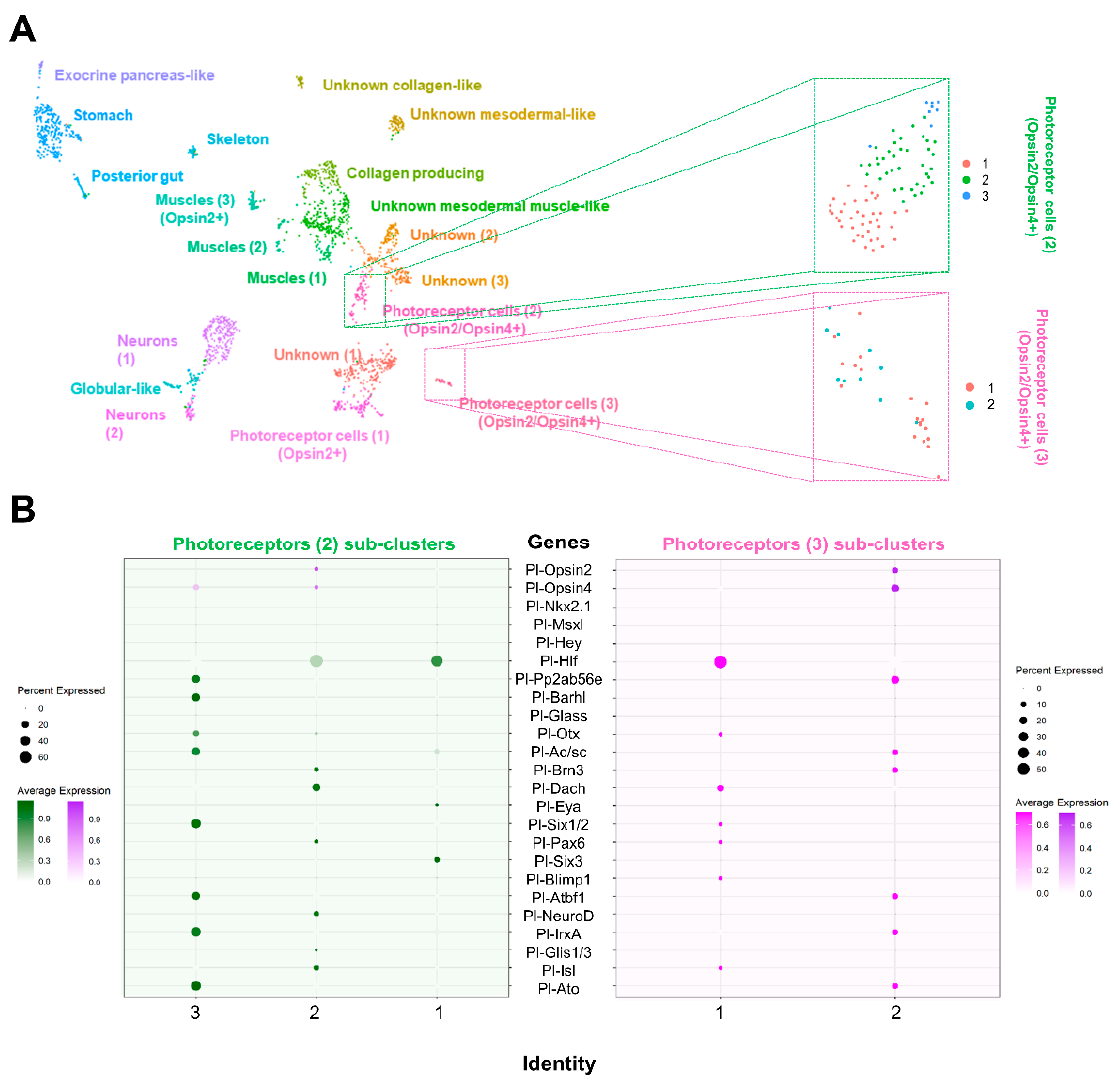
Figure 3. Distinct molecular signature of the two opsin2 / opsin4 double positive cell type families. ( A ) Sub-clustering analysis of the two opsin2/opsin4 double positive cell type families resulted in the generation of the three and two distinct sub-clusters, respectively. ( B ) Dotplot showing the average scaled expression of sea urchin orthologues of retinal genes distributed in the different sub-clusters. Average expression gradient for opsin genes is depicted in purple, while the rest of the genes expressed in PRCs 2 and PRCs 3 sub-clusters are shown in green and magenta, respectively.